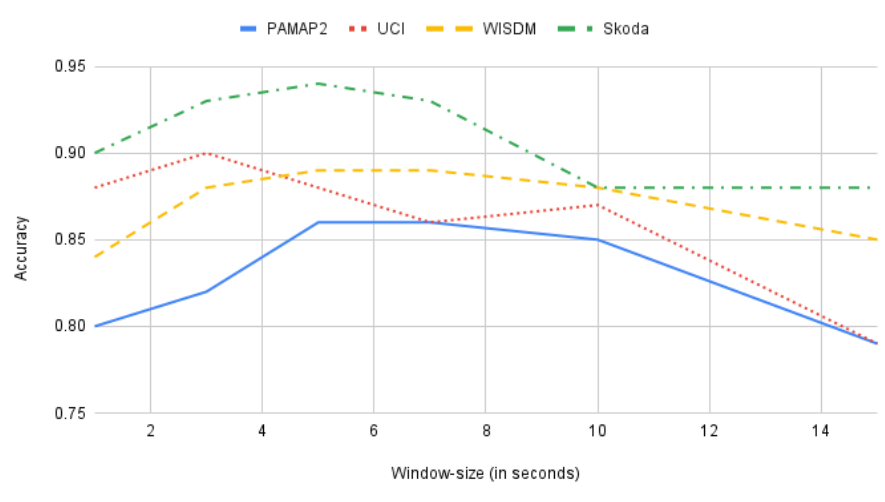
Figure 11. Accuracy (along y -axis) versus window size (in seconds along x -axis) using the best standard baseline architecture for all the